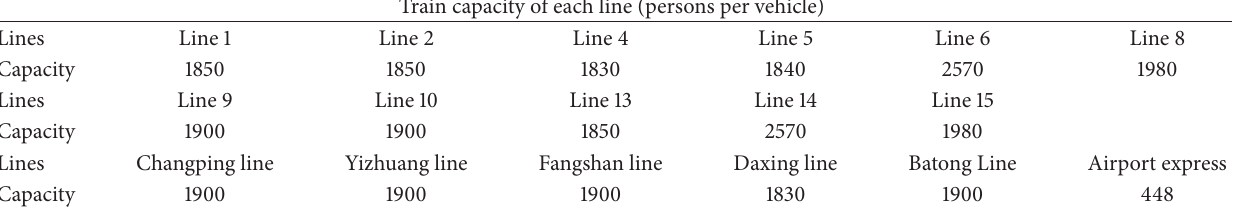
Train capacity of each line (persons per